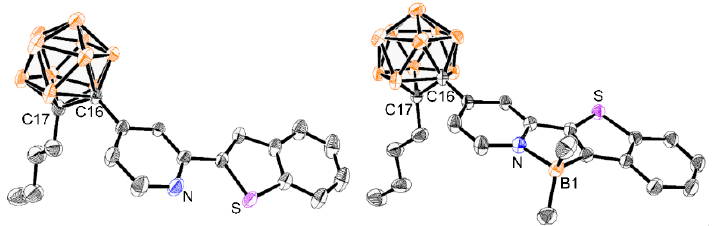
Figure 2. X-ray crystal structures of CB2 (left) and CB2B (right) (50% thermal ellipsoids). H atoms are omitted for clarity.